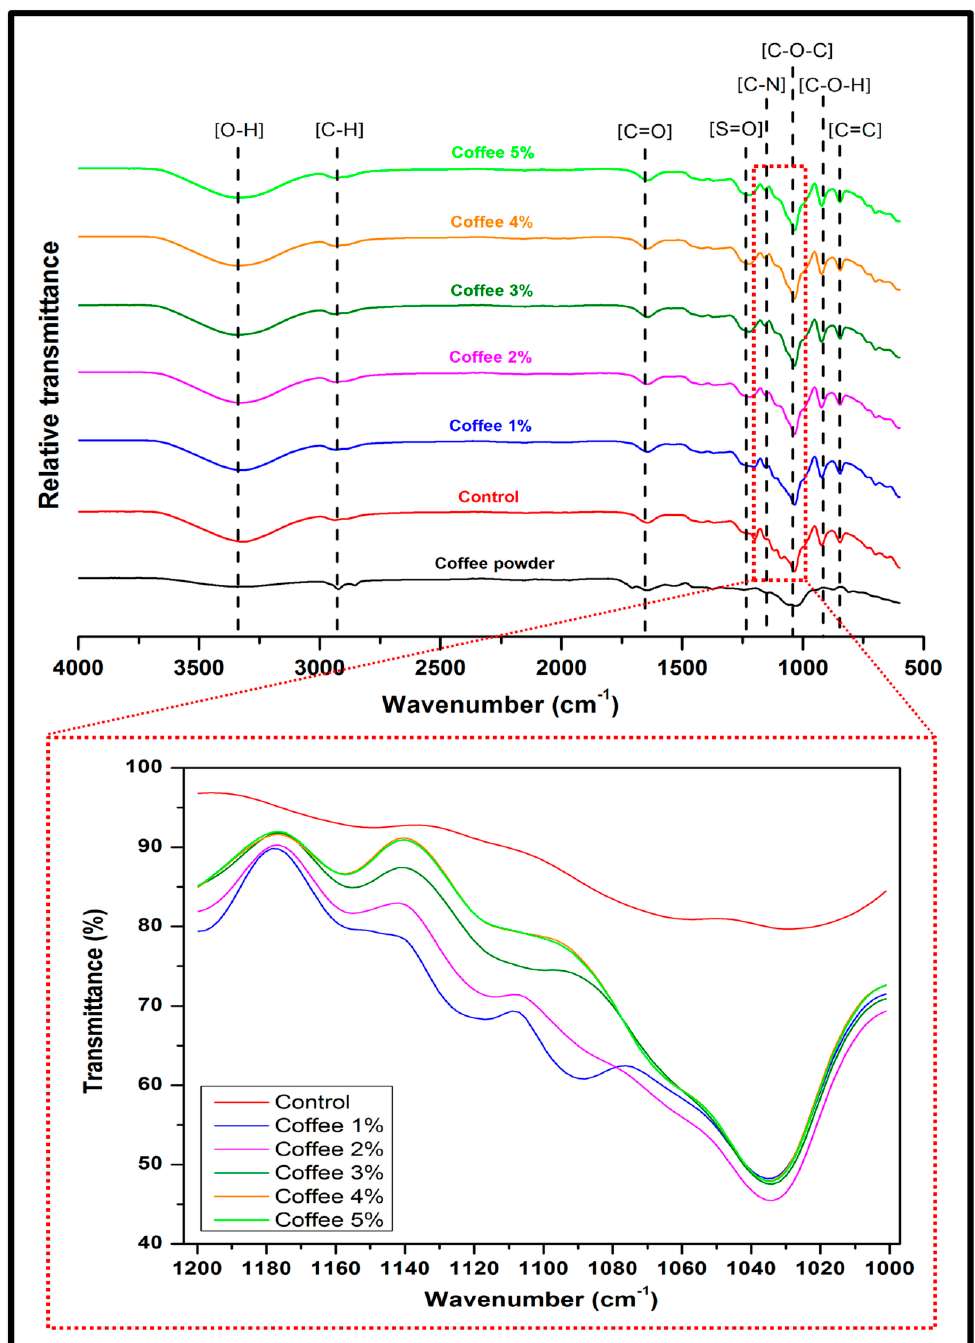
Figure 4. FT-IR spectra of coffee waste powder and seaweed/coffee biopolymer film at various coffee loadings.